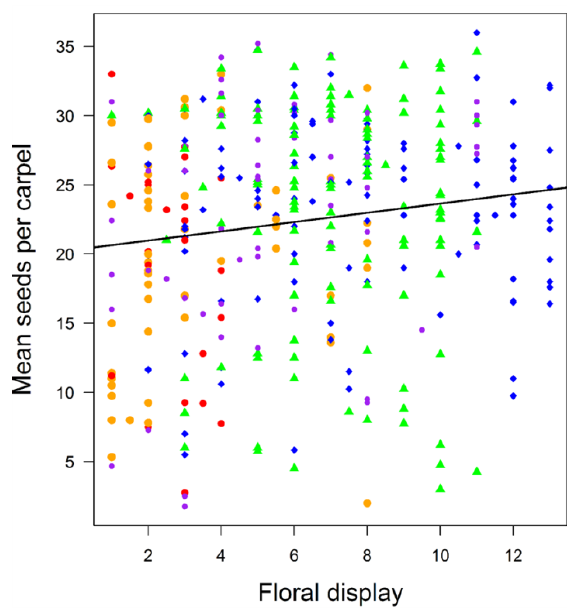
F IGURE 2: Relationship between floral display (# of flowers open at the time the fruit was flowering) and seeds per carpel for each fruit. Line of best-fit is model slope and intercept coefficients (not plotted with a specific site’s random effect slope). Site points are: blue diamond (HCLS), purple small circle (UQV), red large circle (BM), green triangle (CH), and yellow medium circle (OHV). Sample sizes are as in Fig.